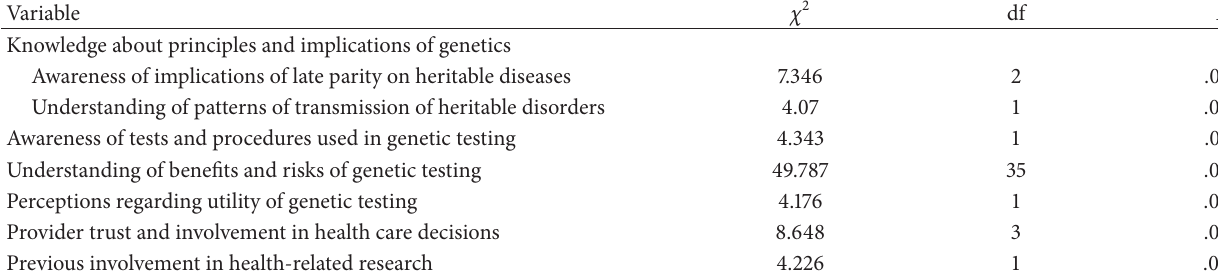
Table 3: Factors associated with willingness to engage in health-related genetic research ( 𝑁 = 212